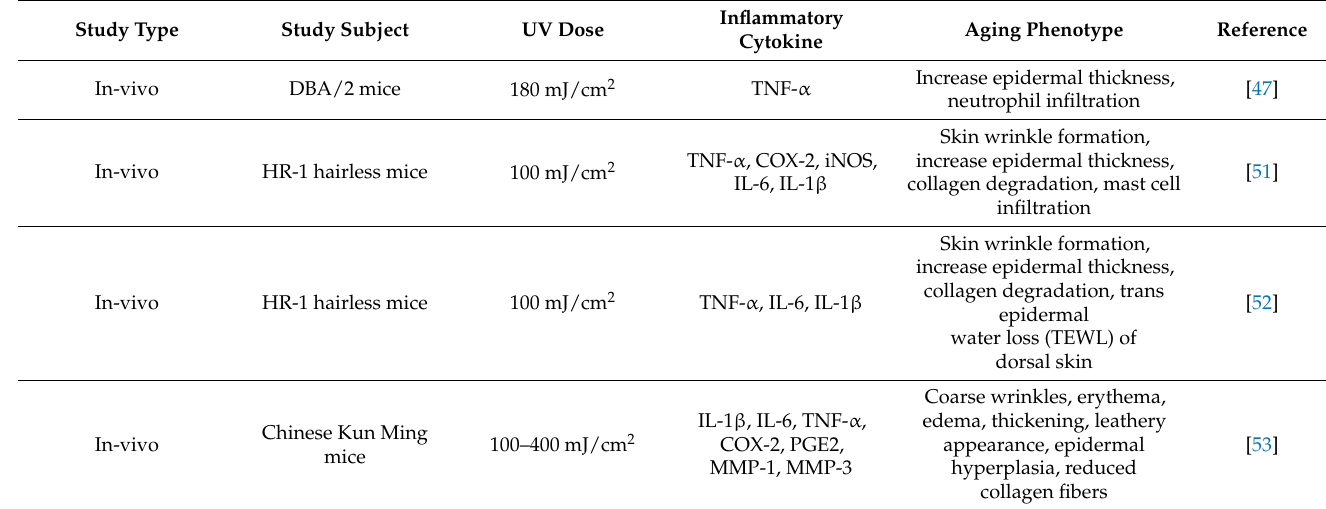
Table 1. Ultraviolet radiation (UVR)-mediated